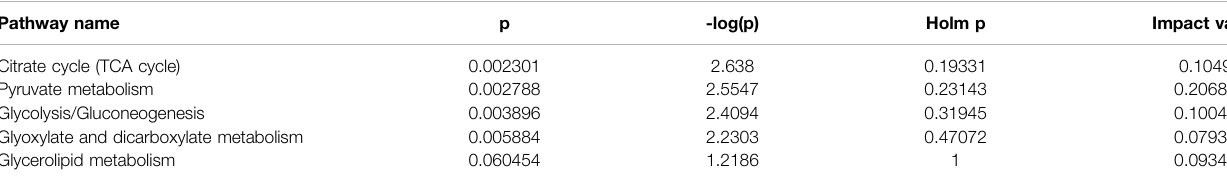
TABLE 3 | Details of the main metabolic pathways obtained from MetPA in cITP